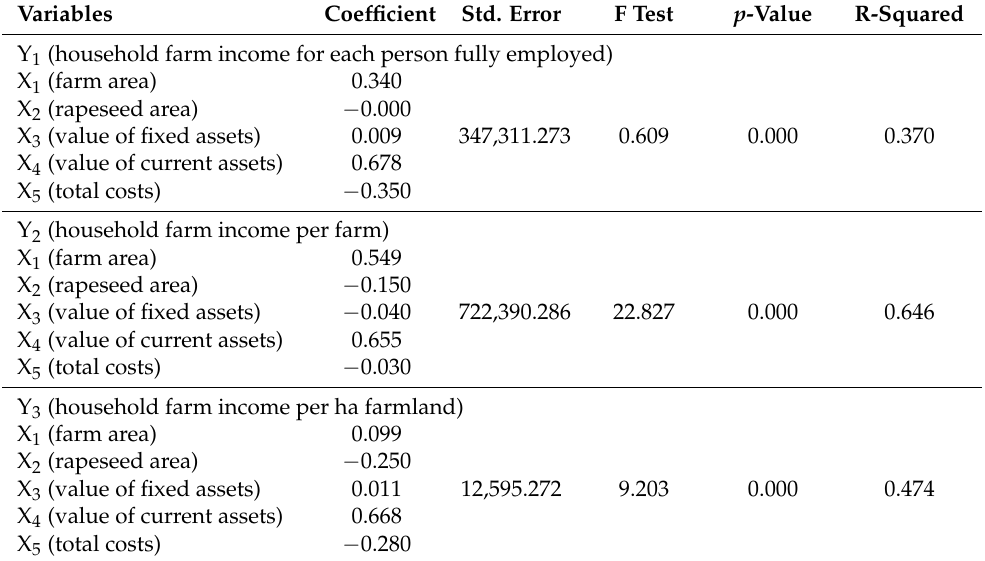
Table 10. The regression